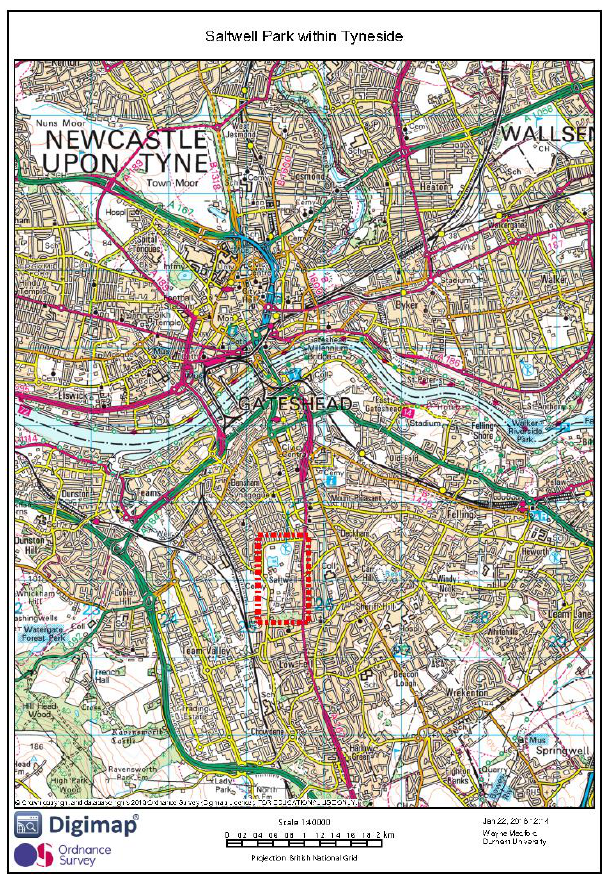
Figure 1. Saltwell Park, Gateshead.